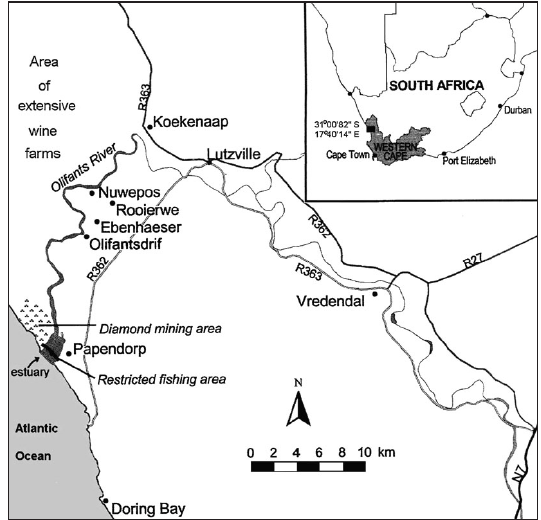
Figure 1. The location of Olifants River Estuary and adjacent fishing communities, Western Cape, South